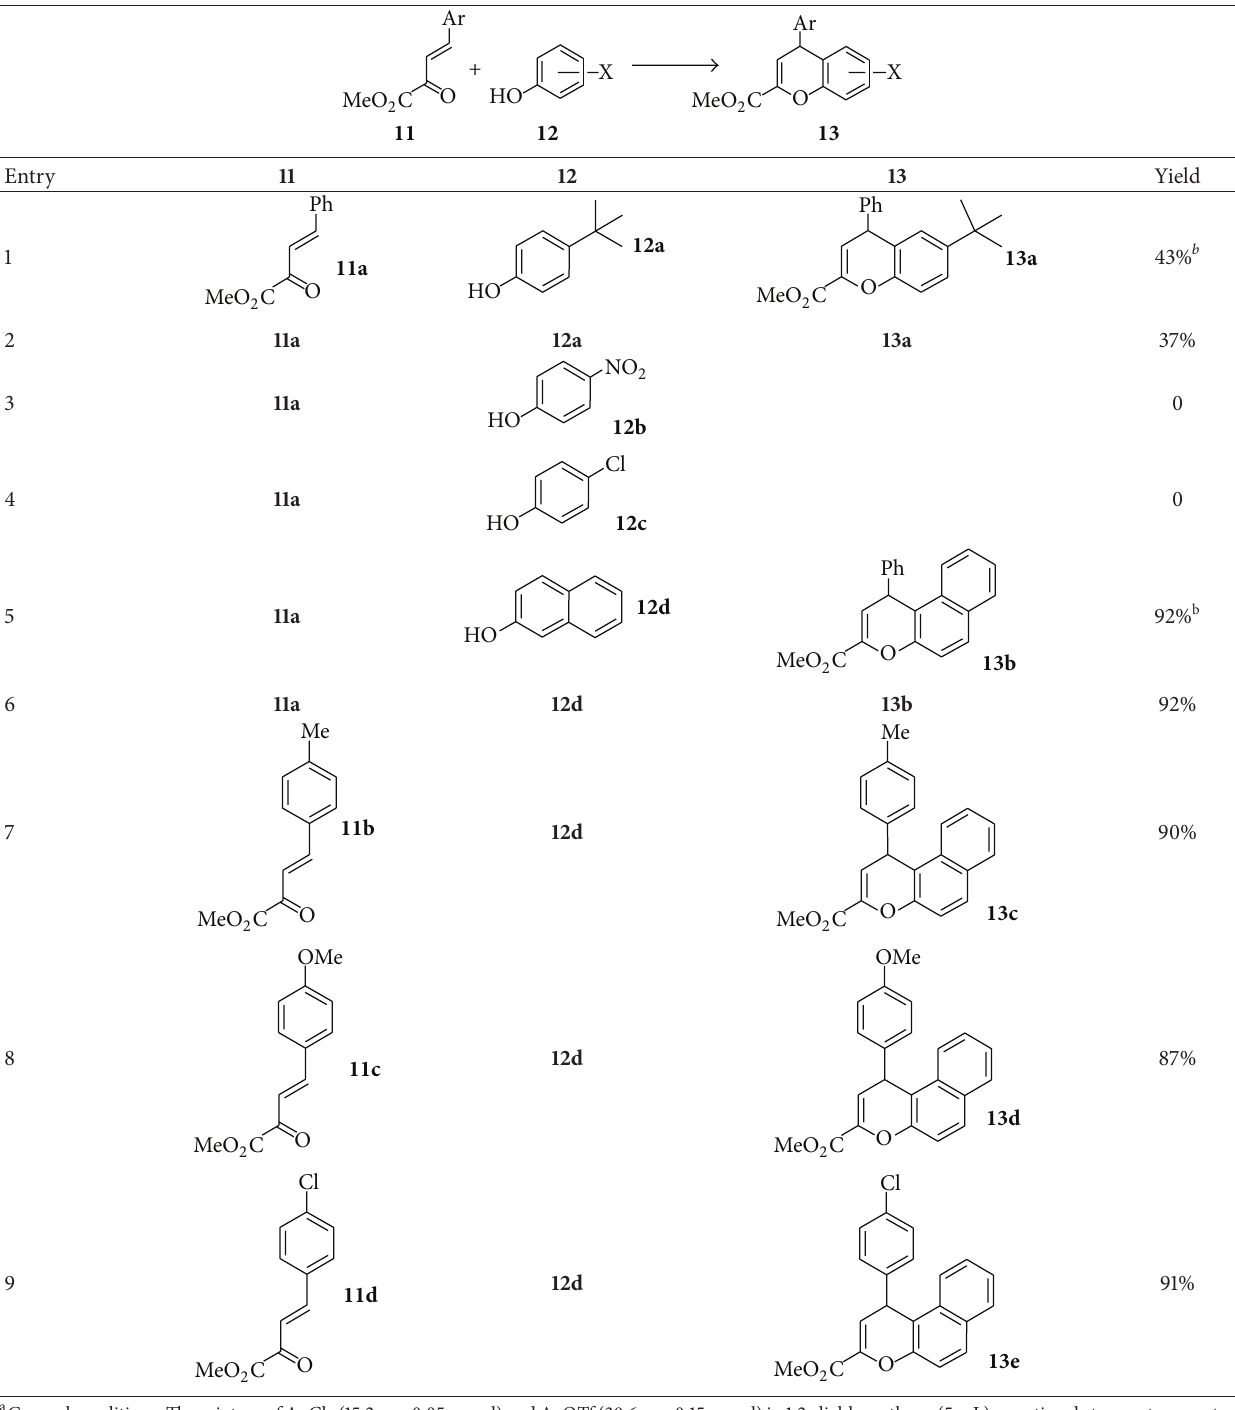
Table 2: Condensation of an 𝛽 , 𝛾 -unsaturated 𝛼 -ketoester 11 with phenol 12 a